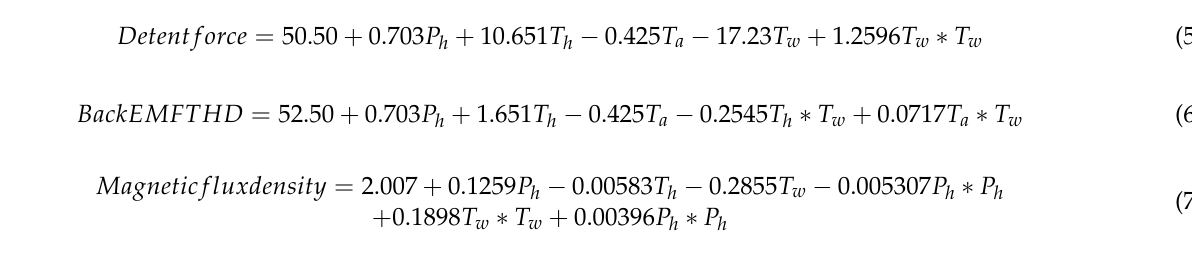
Table 5. Analysis of variance of the detent force.